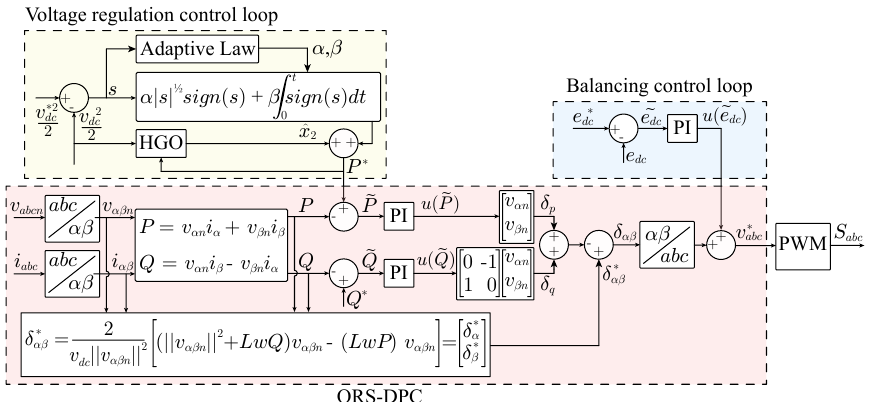
Figure 3. Proposed HGO-Adaptive STA control strategy for three-level NPC converter in AFE